Question: How would you classify this visualization?
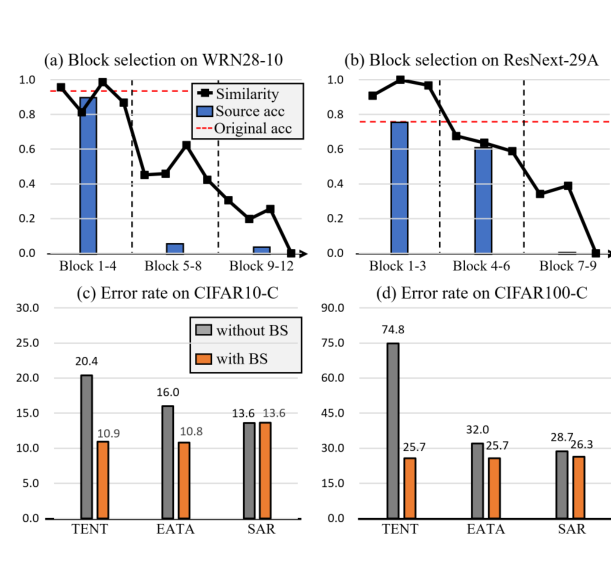
Answer: bar